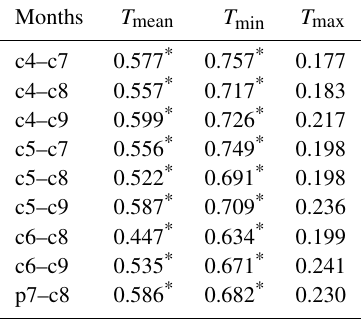
Table 2. Correlation coefficients between the std chronology and the climate data of different month combinations during the